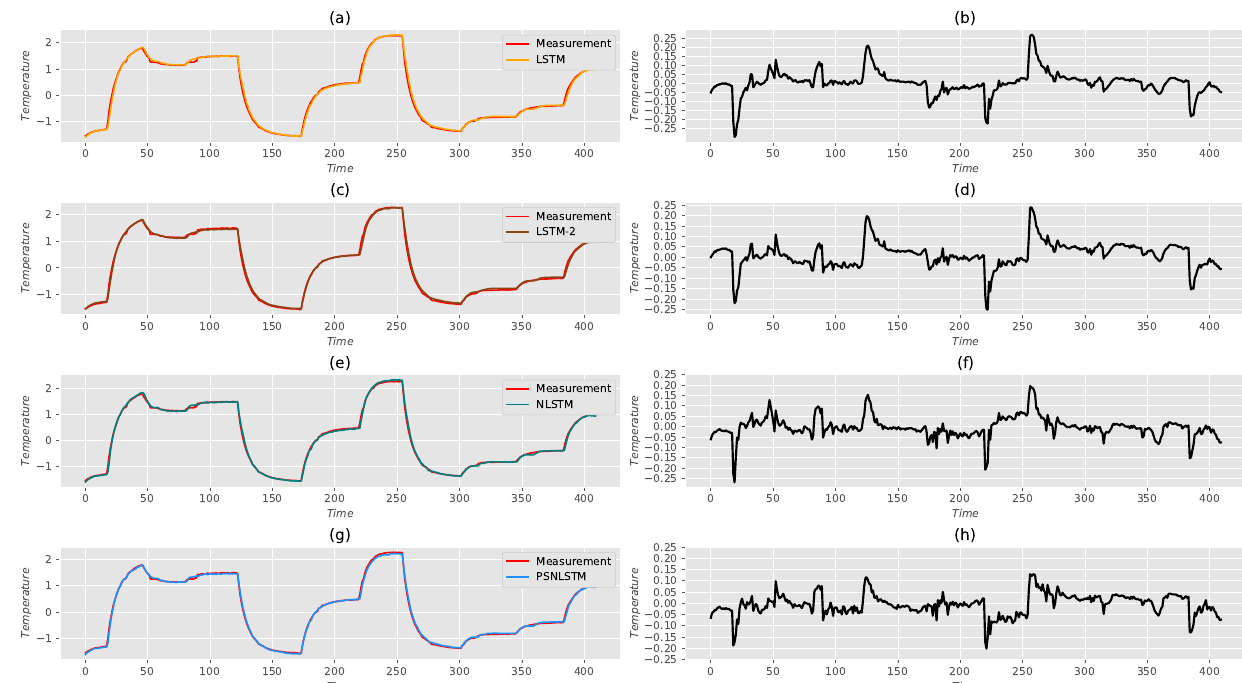
Figure 8. Temperature prediction of ϑ SW for each model. ( a , c , e , g ) the temperature fitting curves of ϑ SW for each model; ( b , d , f , h ) the temperature prediction error curves of the ϑ SW for each model, which are obtained by subtracting the measured values from the predicted values. In addition, the error curves correspond to the left fitting curves,